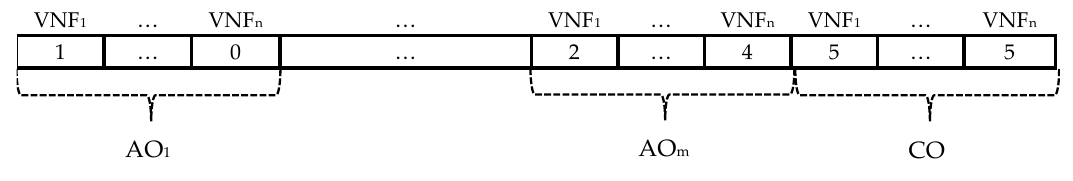
Figure 2. Example of a chromosome.